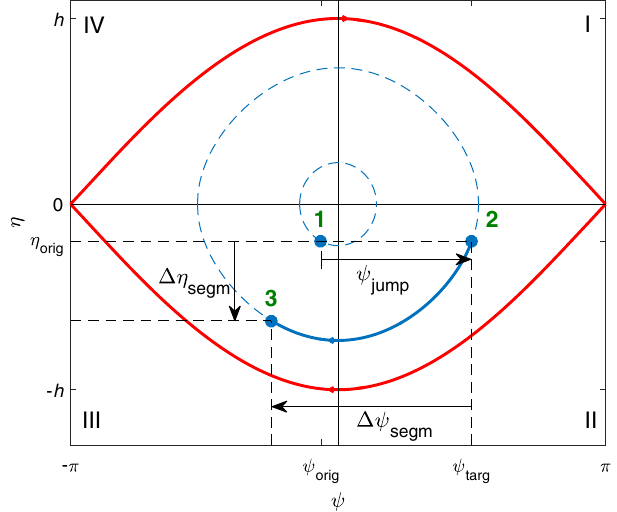
FIG. 3. The microbunch deceleration cycle as illustrated by the movement of the average particle within the ponderomotive bucket. Position 1 corresponds to the starting point of a drift section, position 2 the end point of the same drift section, and position 3 the end point of the subsequent undulator